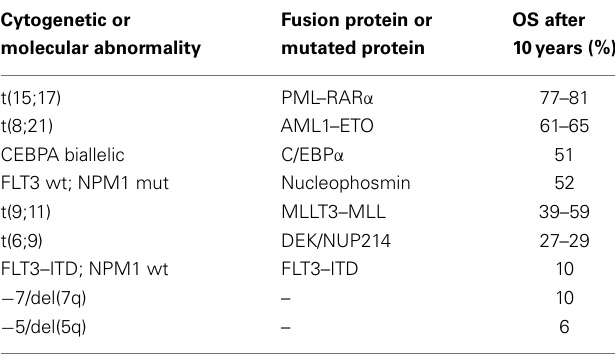
Table 3 | Impact of selected cytogenetic abnormalities on disease outcome based on Ref. (135, 139)